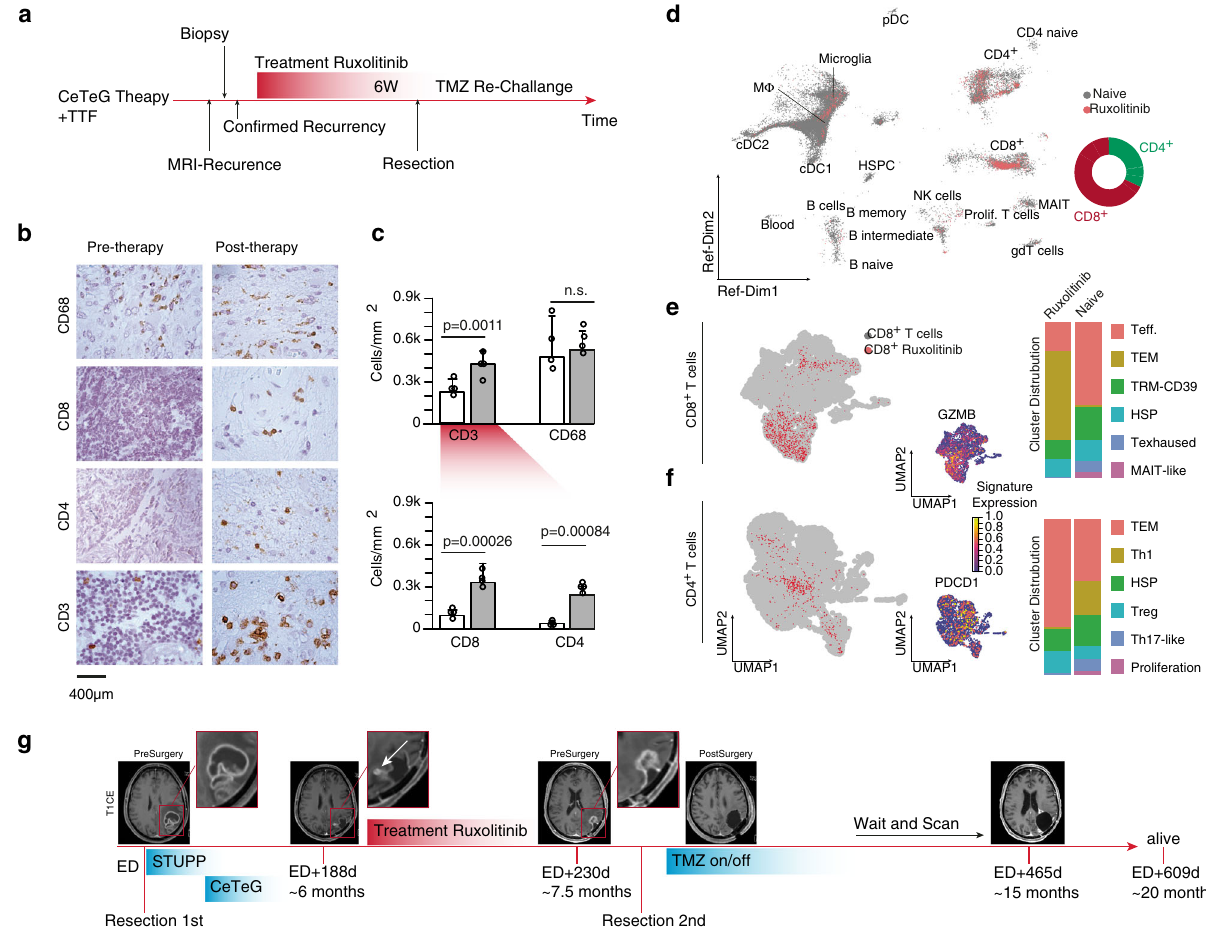
Fig. 7 JAK-STAT inhibition and T cell response in glioblastoma. a Timeline of the treatment of our JAK-inhibition GBM case report. b , c Immunohistochemistry of immune marker and its quanti fi cation ( c ), white: pre-therapy, gray: post-therapy, P values are determined by one-way ANOVA. d Reference UMAP of all T cells (gray) and the JAK-treated patient. A doughnut plot of CD8 + /CD4 + positive cells is illustrated on the right side. e , f Mapping of CD8 + ( e ) and CD4 + ( f ) from the JAK-treated patients to the T cell landscape (left UMAP plot). A quanti fi cation is illustrated on the right side. Typical marker gene expression of T effector (GZMB) and exhausted cells (PDCD1) are illustrated at the bottom. g Clinical follow-up of the